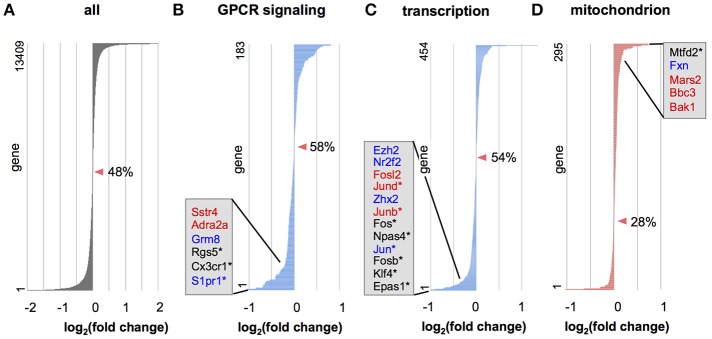
Gene categories dysregulated in Otx2-deficient interneurons. (A–D) Expression changes in Otx2-deficient interneurons in RNA-seq analysis for all genes (A) or in genes involved in the G protein-coupled receptor (GPCR) protein signaling pathway (B), DNA dependent transcription (C) and mitochondria (D). Genes are ordered according to their expression change compared to control interneurons. Zero-crossing points (no change) are indicated by arrowheads. Percentage (%) indicates ratio of decreased genes (fold change < 1) in the gene set. Representative DE genes with Otx2 binding sites (red: P28 only; blue: common to embryo and P28) or DE genes within top 100 as ranked in Table S6 (asterisks) are shown in each category.